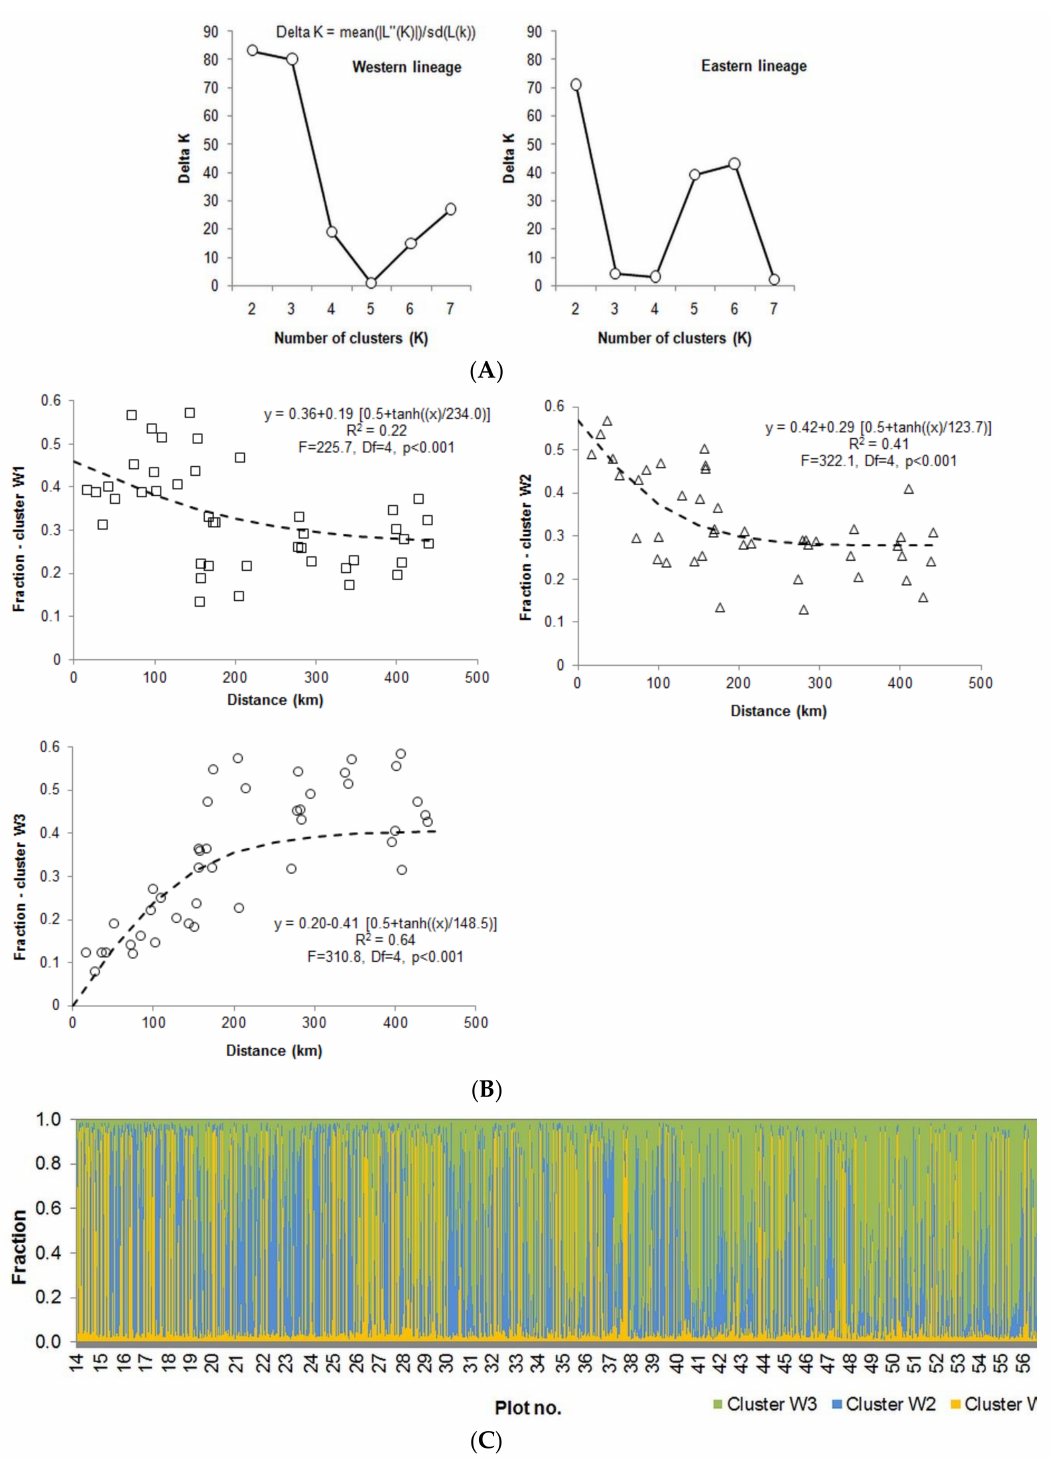
Figure 5. Values of the Delta K criterion in the Bayesian analysis conducted separately for the western and eastern maternal lineages ( A ), frequency of the three genetic groups distinguished by the Bayesian analysis in the western maternal lineage across distance from the contact zone ( B ) and genetic structure of Abies alba subpopulations in the western lineage for K = 3 ( C